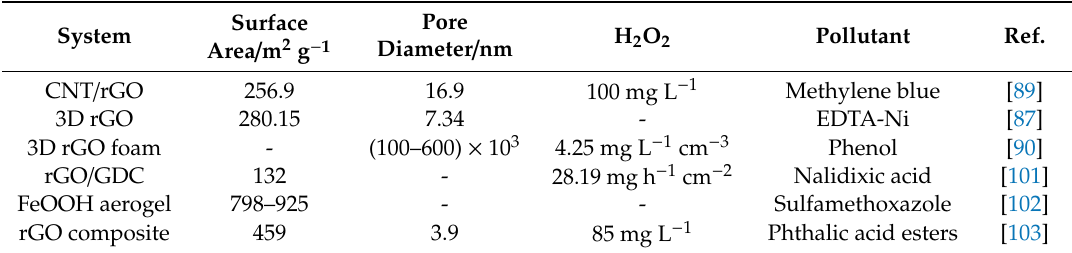
Table 2. Summary of porosity and H 2 O 2 generation rate for various porous graphene-based composites. System